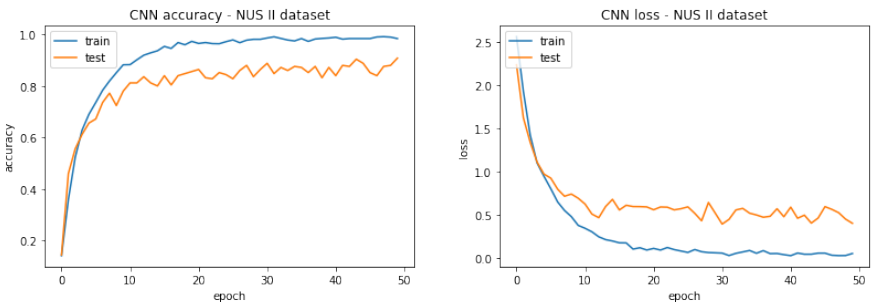
Figure 13. Diagnostic curves for CNN-NUS II dataset.